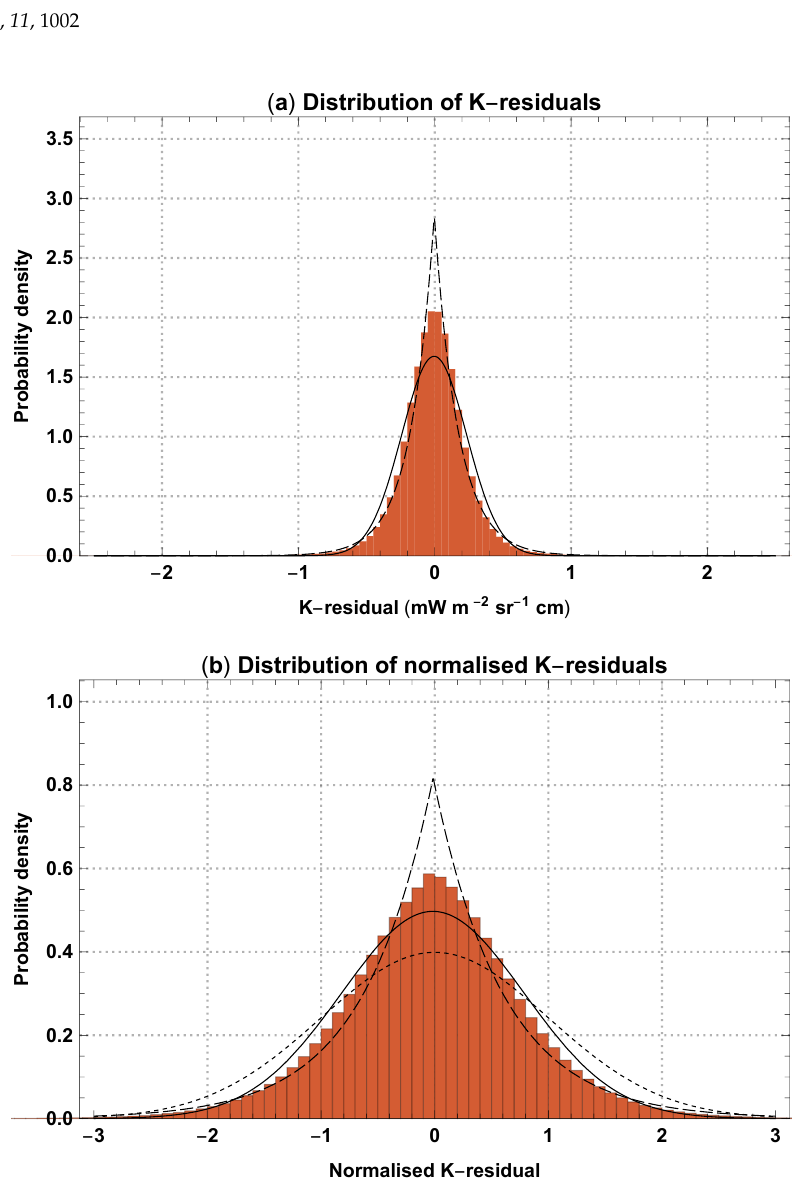
Figure 5. ( a ) top panel: distribution of harmonised K -residuals for all sensor pairs. The solid and dashed lines mark normal and Laplace distributions, which have the same mean and the same dispersion as the distribution of K -residuals; ( b ) bottom panel: as above but showing the distribution of uncertainty-normalised K -residuals. The dotted curve marks the standard normal